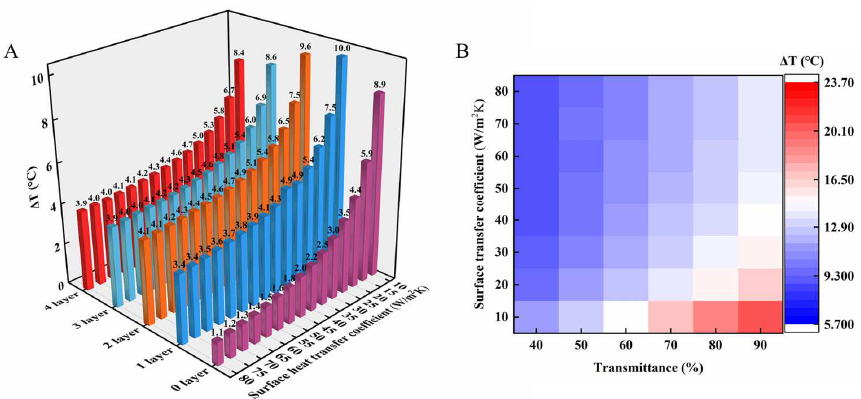
Figure 6. ( A ) Model calculation: cooling histogram of samples with different ℎ (cid:12) and different layers of bubble film insulation. ( B ) Model calculation: cooling forecast hotspot diagram with different ℎ (cid:12) and different transmittance (8–13 μm) of HPF.